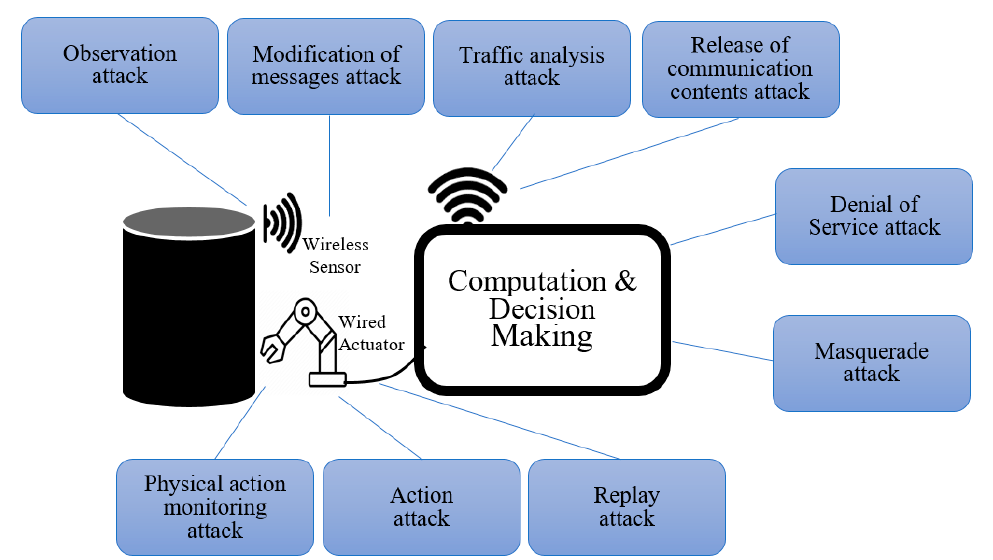
Figure 4. CPS components with possible passive and active security attacks.